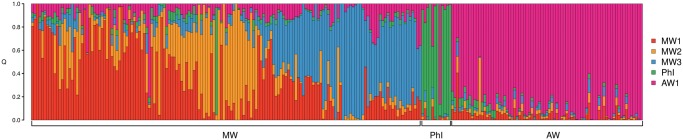
Spatial population clustering and ancestry coefficients estimated with TESS3 using the best number of subpopulations (K = 5). The genotypes are sorted by latitude from Northern Mexico to Northwestern Argentina. MW, Mesoamerican wild; AW, Andean wild; PhI, Northern Peru-Ecuador.